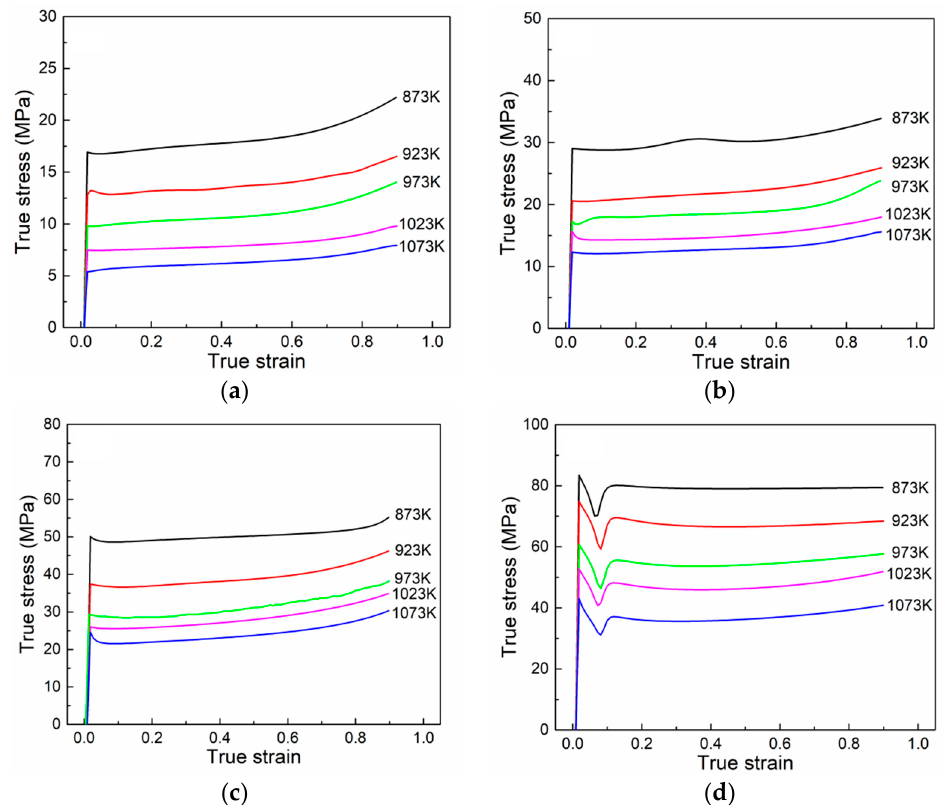
Figure 2. True stress–strain curves of Cu-Ni-Al brass alloy under different strain rates, ( a ) 0.01 s − 1 , ( b ) 0.1 s − 1 , ( c ) 1 s − 1 , ( d ) 10 s − 1 .